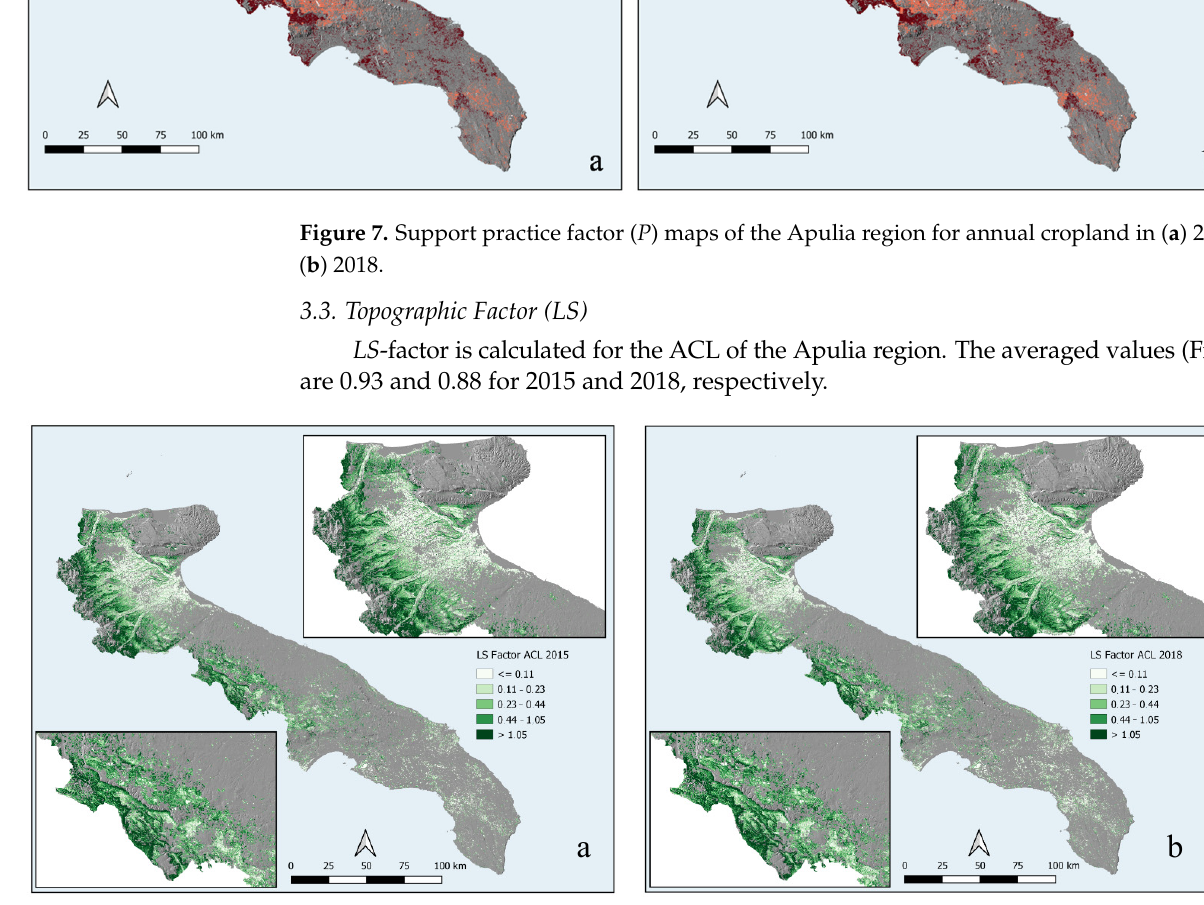
Figure 8. Slope length and steepness ( LS ) factor map of the Apulia region for annual cropland in ( a ) 2015 and ( b ) 2018.